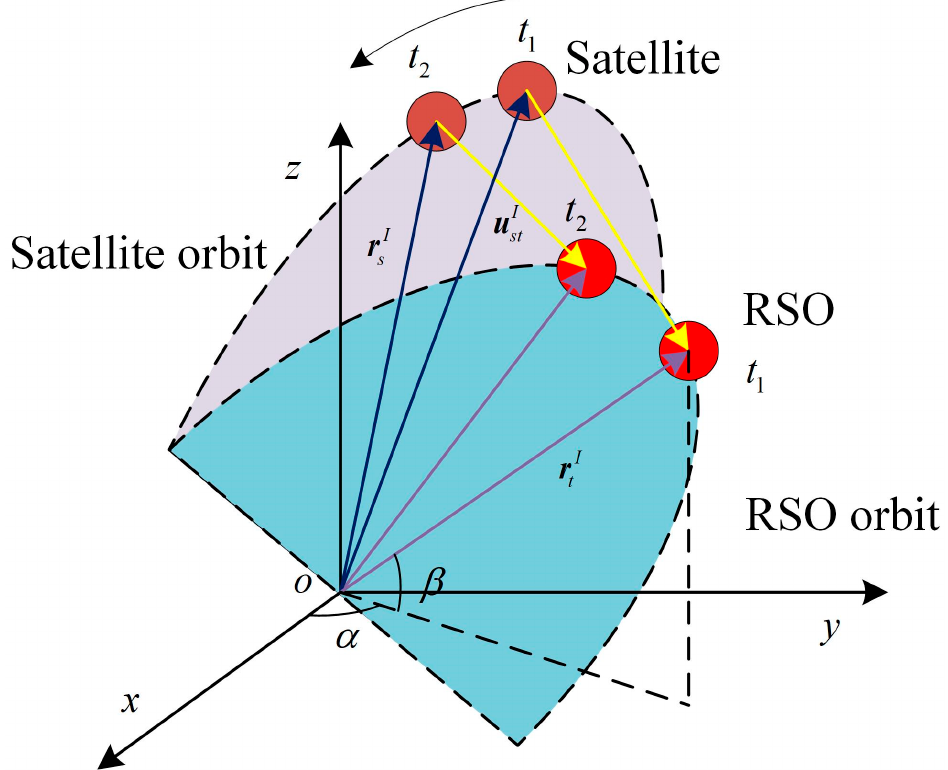
Figure 4. Schematic of staring–tracking to the RSO. I r t